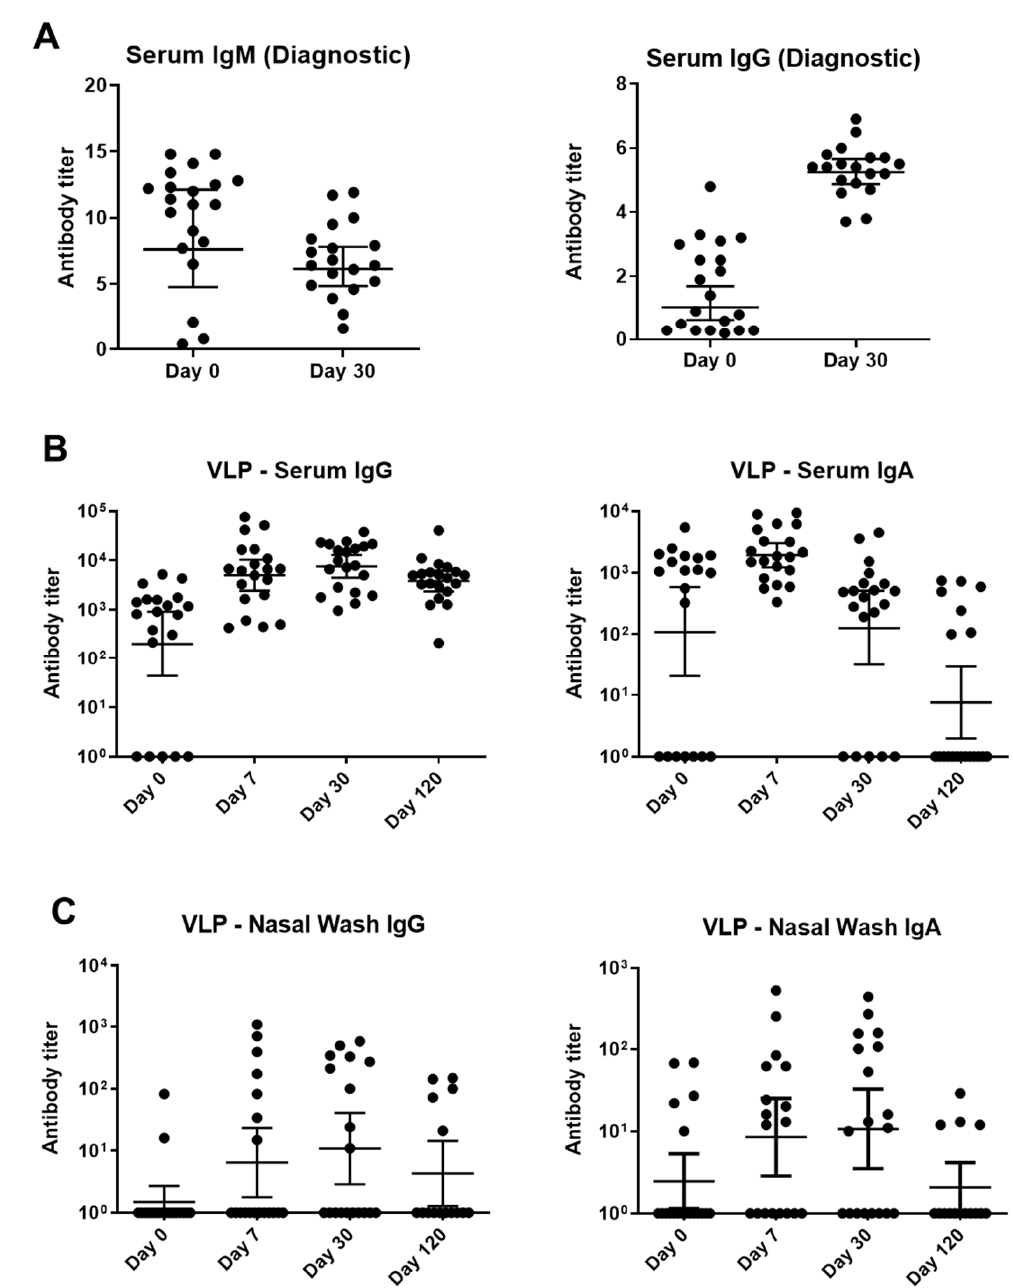
Figure 3. Binding antibody responses to parvovirus B19 infections among children with SCD and TAC. ( A ) A Biotrin kit-based ELISA with a baculovirus-vectored, insect cell-expressed parvovirus B19 VP2 antigen was performed at a commercial, CLIA-certified laboratory. Virus-specific IgM (left) and IgG (right) were detected. ( B , C ) Samples were tested against Prospec VP1/VP2 VLP in ELISAs. These VLPs were produced in SF9 insect cells. Sera ( B ) and nasal washes ( C ) from longitudinal patient samples were tested for IgG and IgA. Titers below detection in each assay were assigned a value of 10 ◦ . Geometric means are shown with 95% confidence